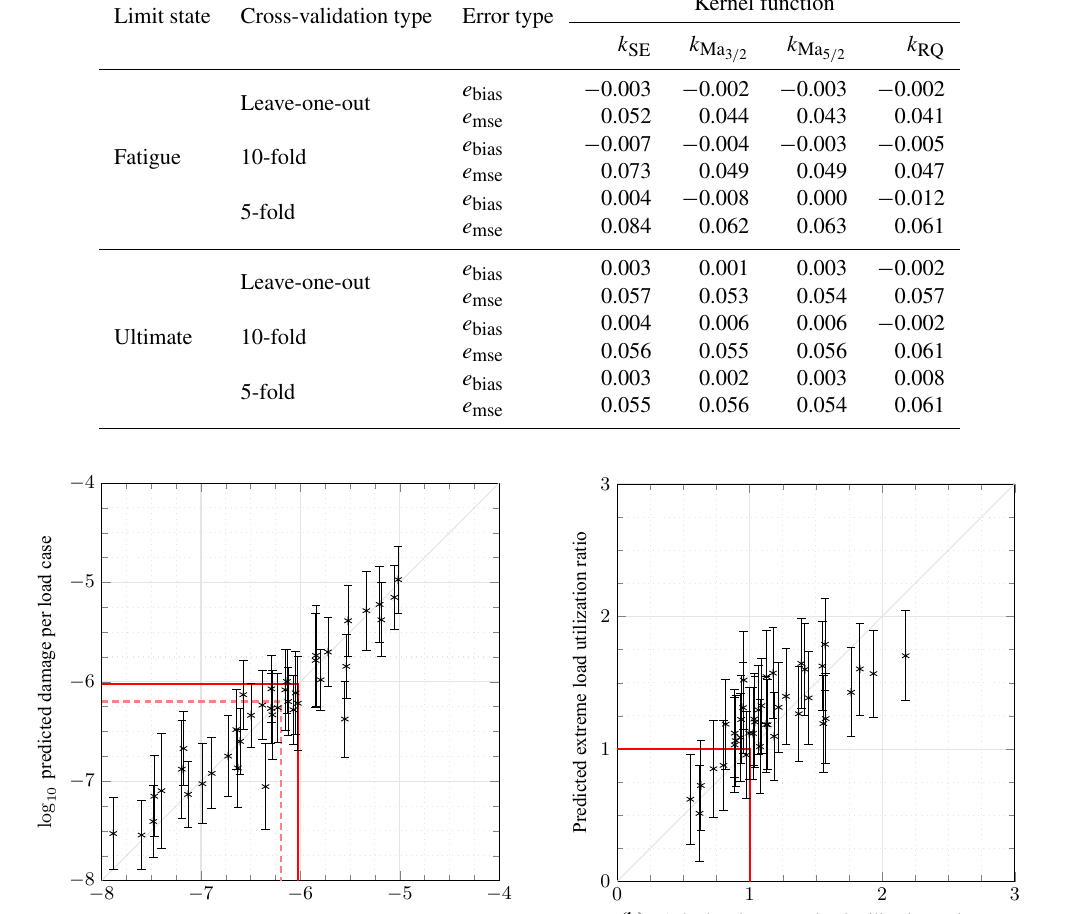
Figure 6. Prediction results for all samples of the validation set. Asterisks depict mean predicted damages in the first and mean extreme load utilization ratios in the second plot, and whisker ranges illustrate the 95% significance intervals. The solid red line illustrates the critical damage related to a 20-year lifetime of the structure or a utilization ratio of 1. Moreover, the 30-year damage is illustrated with a dashed red line in the first plot.